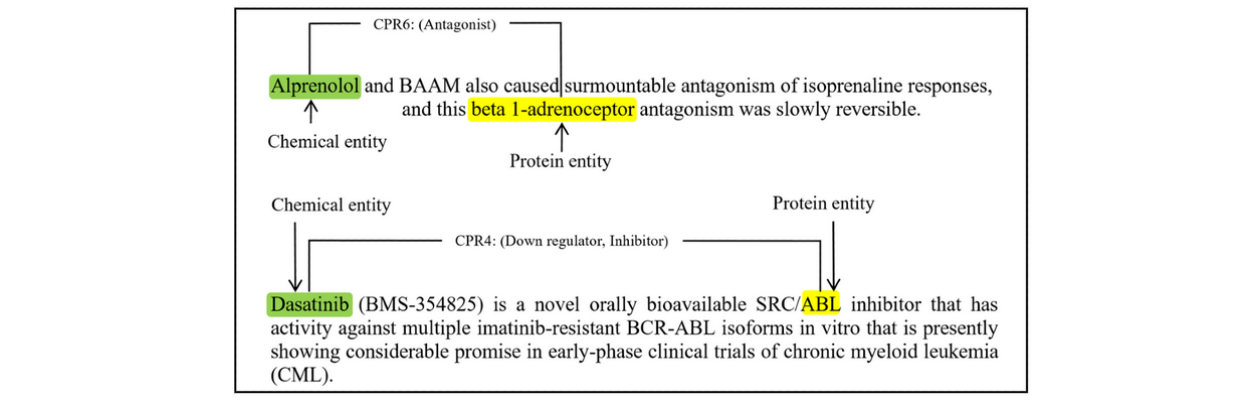
Figure 3. Illustrative examples of chemical-protein relation (CPR) classes.